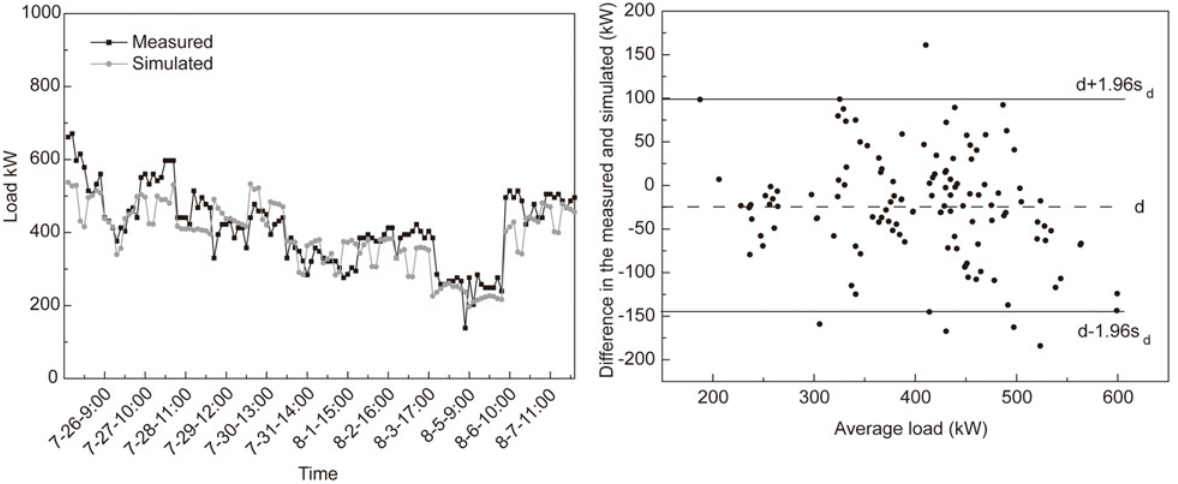
Fig 2. Comparisons between hourly measured and simulated cooling loads during the period from 26 July — 7 August in 2010 (a) and the Bland- Altman plot of the measured and simulated loads (b). The upper and lower solid lines in Fig 2b represent the limits of agreement, and the middle horizontal dashed line shows the mean